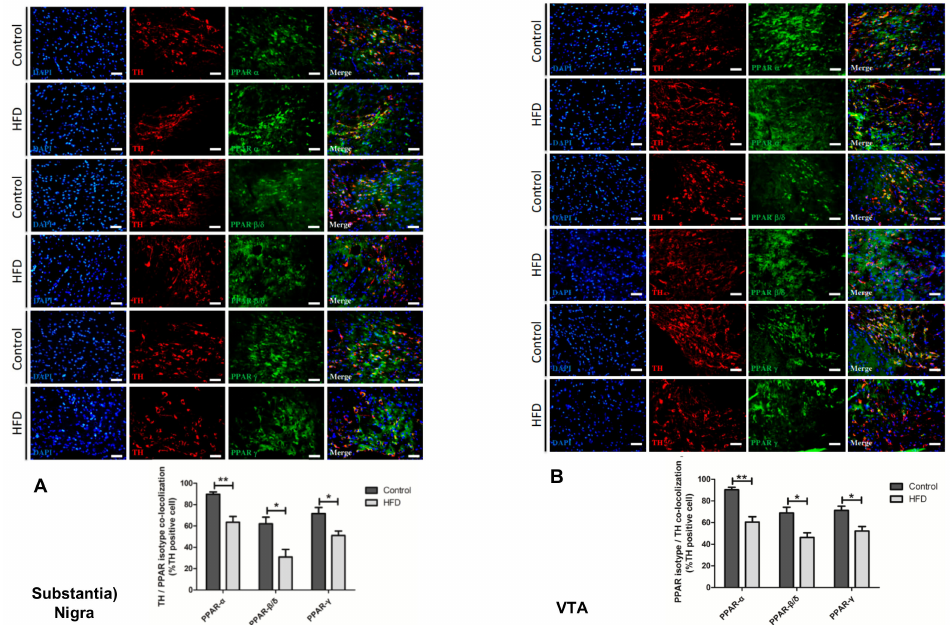
Figure 6. Evaluation of peroxisome proliferator-activated receptor (PPAR) isotype expression in the dopaminergic neurons of the SN and ventral tegmental area (VTA) using anti-PPAR antibodies. Immunofluorescence showed that TH neurons (second panels, coded in red) and PPAR (third panels, coded in green) were colocalized (right panels, merge images coded in yellow-orange). (cid:48) ,6-diamidino-2-phenylindole was used as a counterstain (left panel, indicated by blue nuclei). Using antibodies against each PPAR isotype, levels of all the PPAR isotypes were found to be significantly decreased in the SN ( A ) and VTA ( B ) of HFD mice, compared to those in the controls. Confocal microscopy (30 × ), scale bar = 100 µ m. The asterisks represent the level of statistical significance calculated using a two-tailed Student’s t -test (* p < 0.05, ** p < 0.01); data are represented as mean ± SD ( n = 5 in each group). PPAR: peroxisome proliferator-activated receptor; VTA: ventral tegmental